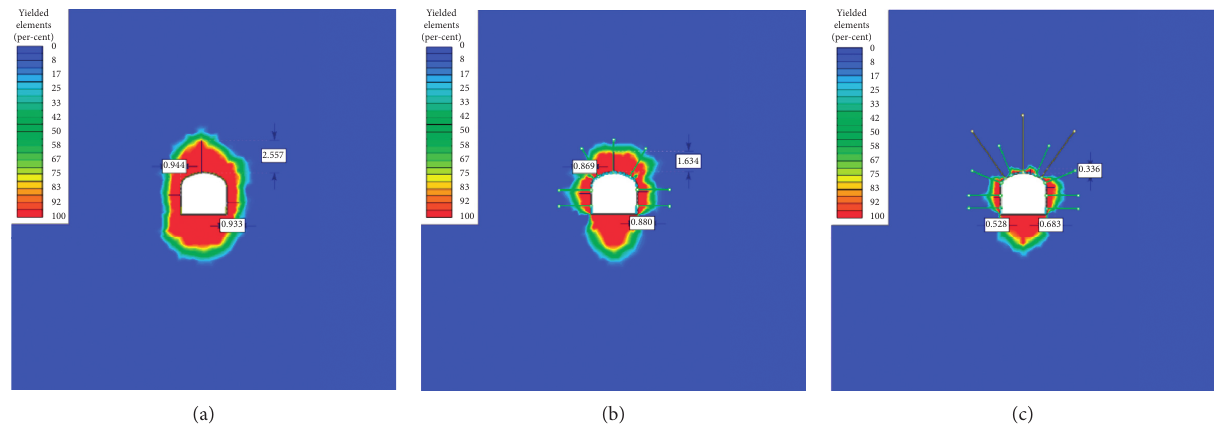
Figure 10: Depth of plastic zone surrounding the drift for (a) sophisticated support, (b) support suggested by Q-system, and (c) the combination support system.